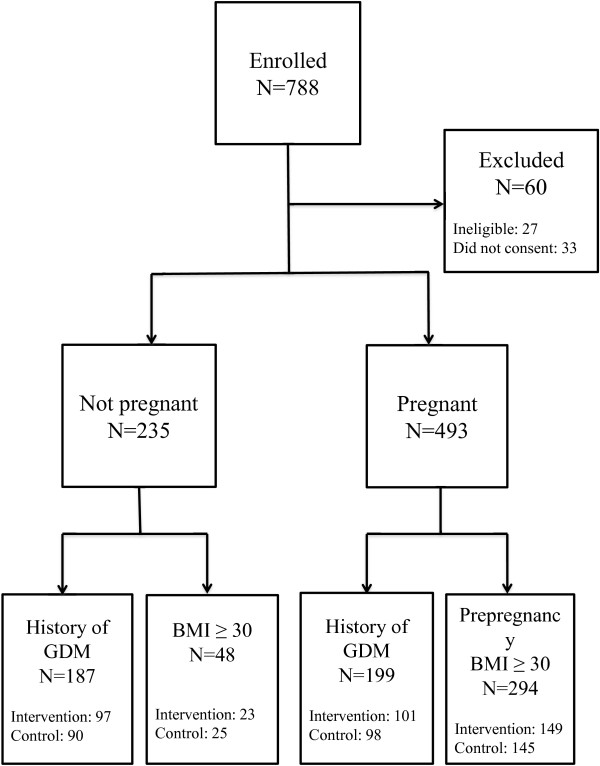
Flow chart of participant recruitment. GDM = gestational diabetes, BMI = body mass index.